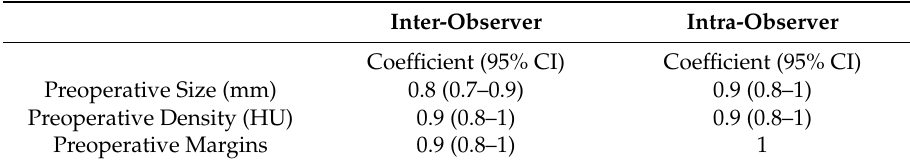
Table A1. Inter- and intra-observer